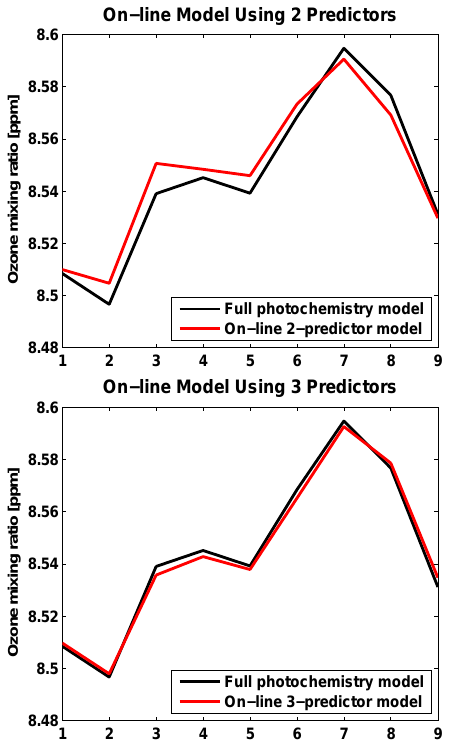
Fig. 8. Illustration of the performance of the statistical model when used on-line for days 1 to 9 at 37km altitude, for a member simula- tion chosen randomly in the ensemble used in Fig. 7. Black: ozone mixing ratio from the control simulation. Red: ozone mixing ratio with the solar variability represented by the 2-predictor model (top) and the 3-predictor model